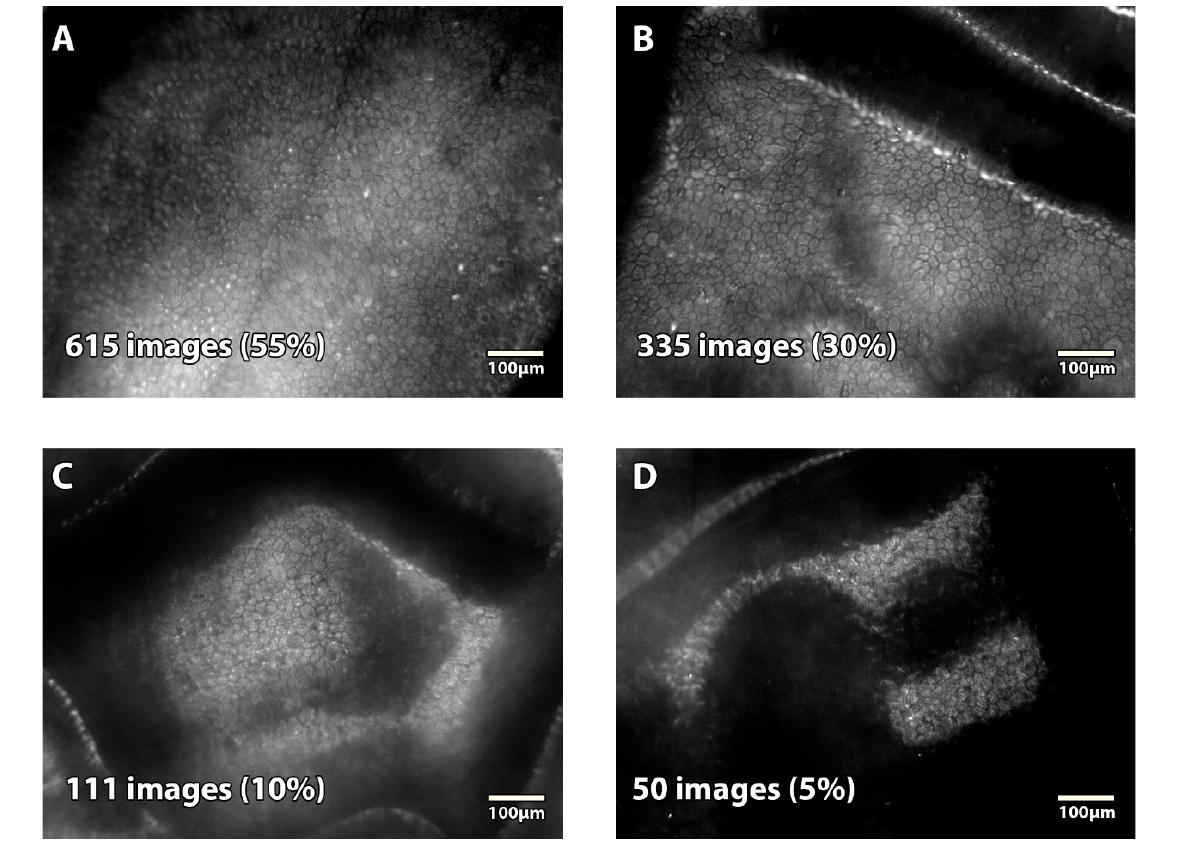
Figure 4. Representative image quality obtained with the prototype specular microscope on corneas stored in the active storage machine . Grading was done using criteria of the Specular Microscopy Ancillary Study [14,15]. ( A ) Excellent-quality image with an ECD of 3022 cell/mm 2 . ( B ) Good-quality image with an ECD of 2637 cell/mm 2 . ( C ) Fair-quality image with an ECD of 2689 cell/mm 2 . ( D ) Unanalyzable image. Table 1. Image quality classification obtained with specular microscopy of corneas stored in the active storage machine.